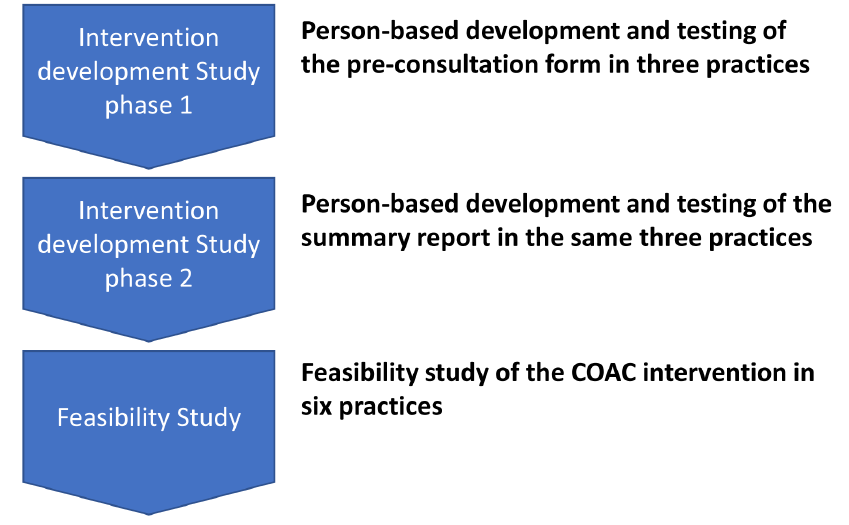
Figure 1. The Intervention Development and Feasibility